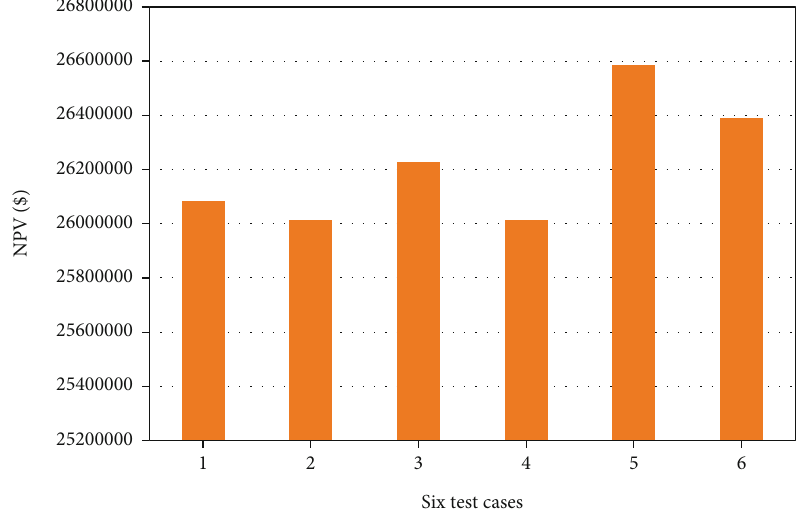
Figure 6: The maximum NPV after 50 iterations for di ff erent